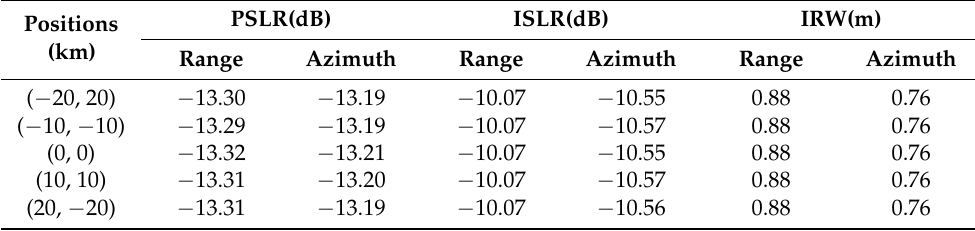
Figure 22. Focusing results with the range model proposed in this paper for 2000 s integration time at 55° of true anomaly. Table 5. Evaluation parameters of point targets by the imaging method proposed in this paper.